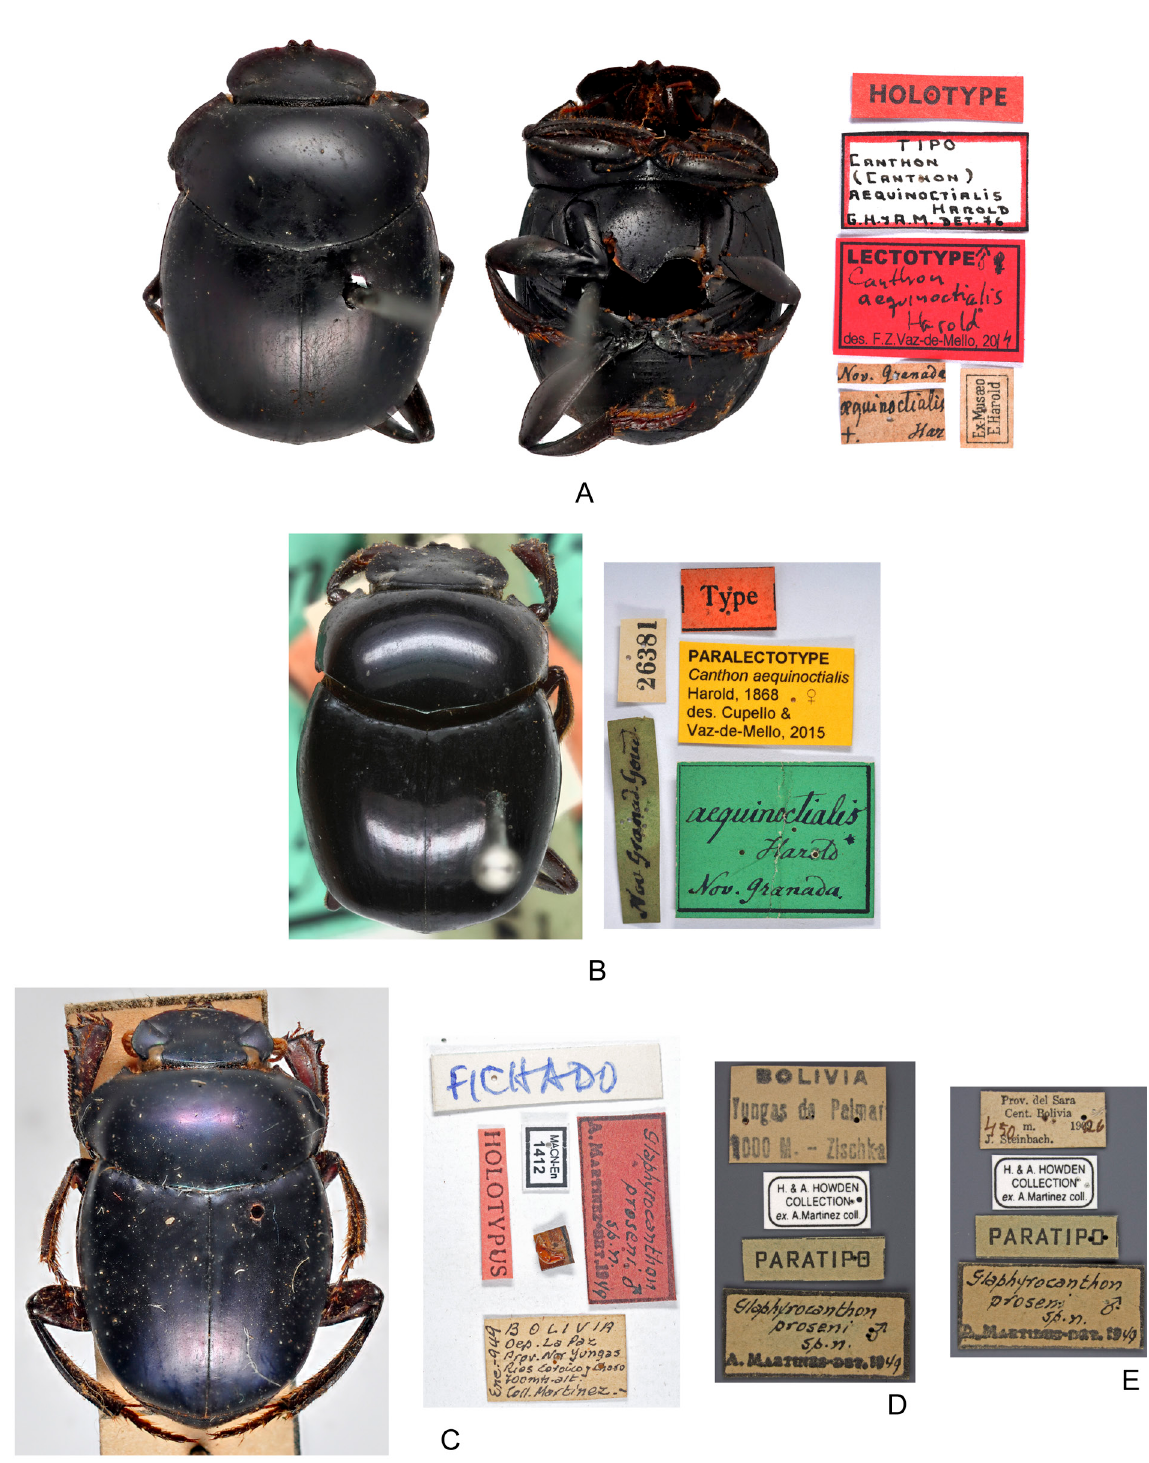
Fig. 29. Type material of the aequinoctialis subgroup. A–B . Sylvicanthon aequinoctialis (Harold, 1868) comb. nov., type series. A . Lectotype and its labels. B . Paralectotype and its labels. C–E . S. proseni (Martínez, 1949) stat. et comb. nov., type series. C . Holotype and its labels. D . Paratype 1. E .